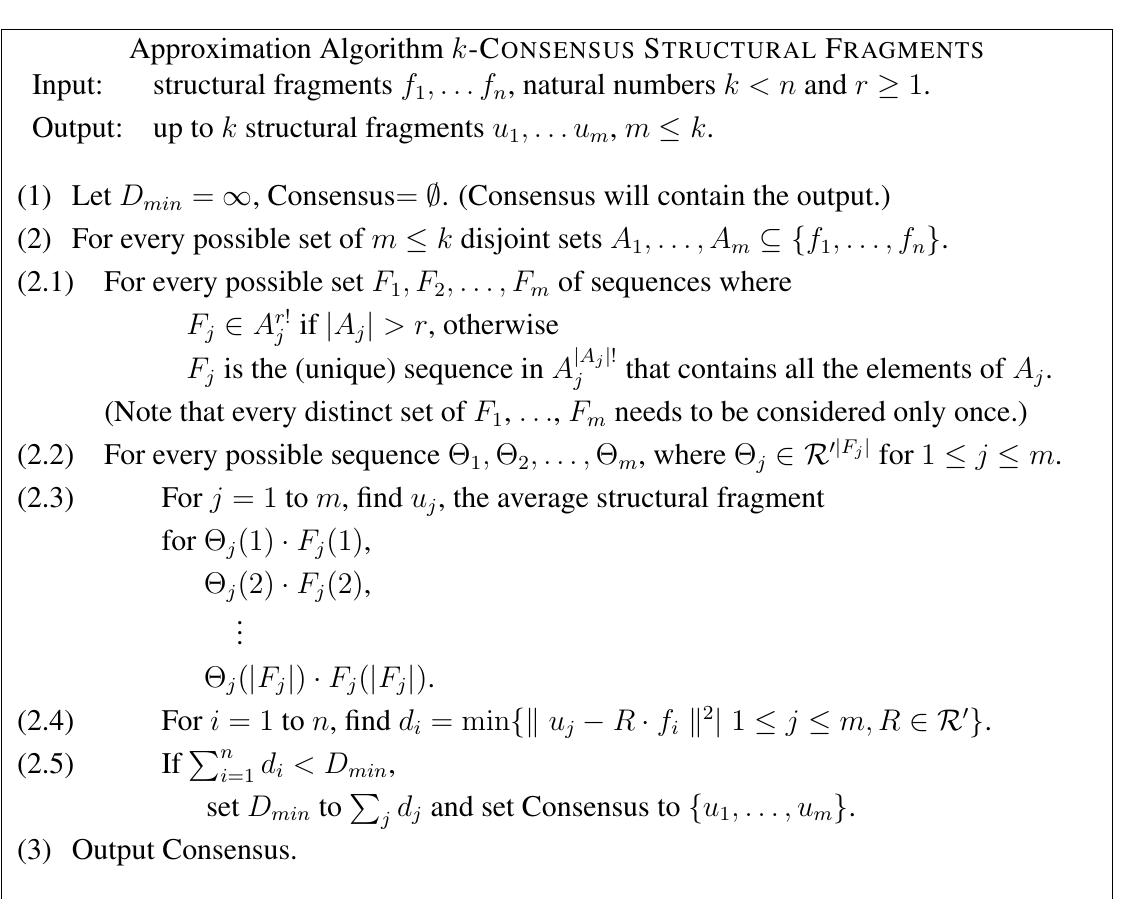
Table 1 . Polynomial-time algorithm for the